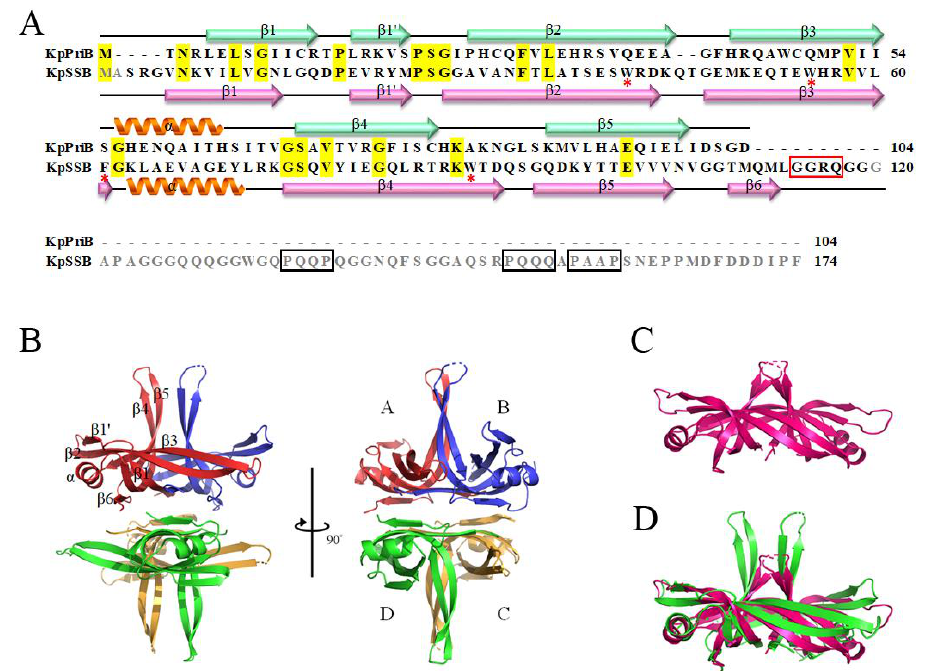
Figure 2. Structural comparison of KpSSB and KpPriB. ( A ) Sequence alignment of KpPriB and KpSSB. Identical residues between KpPriB and KpSSB are shaded in yellow. The corresponding PXXP motifs in KpSSB are boxed in black. The GGRQ motif is boxed in red. The secondary structural elements of KpPriB and KpSSB are shown with the sequences. The amino acids 120 – 174 (in gray) in the structure of KpSSB were not observed. ( B ) Crystal structure of KpSSB (PDB entry 7F2N). Four monomers of KpSSB were found per asymmetric unit. The KpSSB monomer has an OB-fold domain similar to EcSSB, and the core of the OB-fold domain possesses a β -barrel capped with an α -helix. The amino acids 120–174 in the structure of KpSSB were not observed. ( C ) Crystal structure of KpPriB (PDB entry 4APV). ( D ) The superimposed structures of KpPriB and the KpSSB dimer. The KpSSBn and KpPriB are similar, in which the only significant difference is in the lengths of the β 4 and β 5